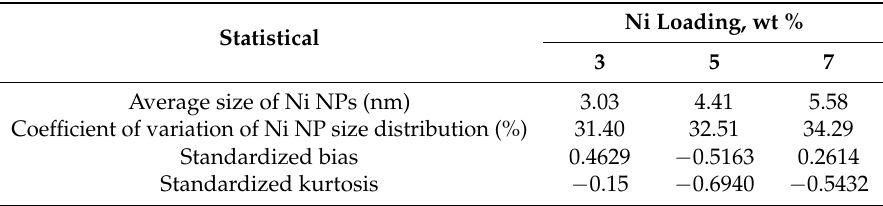
Table 2. Statistical analysis for Ni nanoparticles size deposited on γ -Al 2 O 3